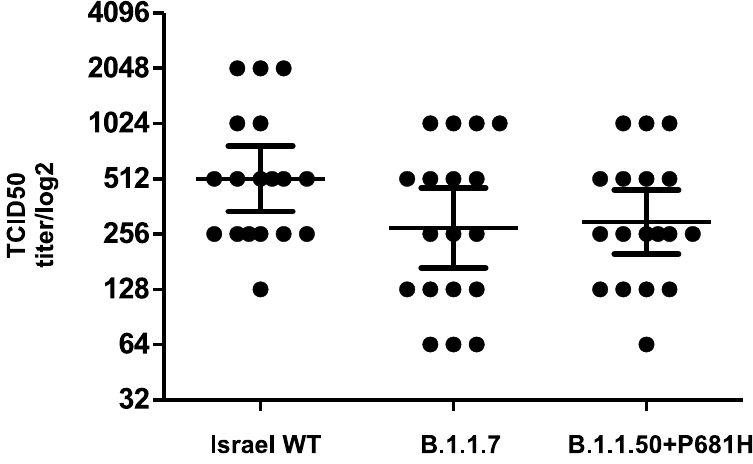
Figure 3. Neutralization of the B.1.1.50 + P681H variant. Neutralization assays were carried out with VERO-E6 cells infected with the B.1.1.50 + P681H variant, B.1.1.7 variant and an Israel WT strain from Israel, using sera from fully vaccinated individuals. On day 6, plates were colorized overnight with Gentian violet +4% formaldehyde solution for virus neutralization. Titers were calculated by qualitative measurements of the cytopathic effect for each patient. Bars represent the geometric mean titer (GMT) and 95% confidence intervals.